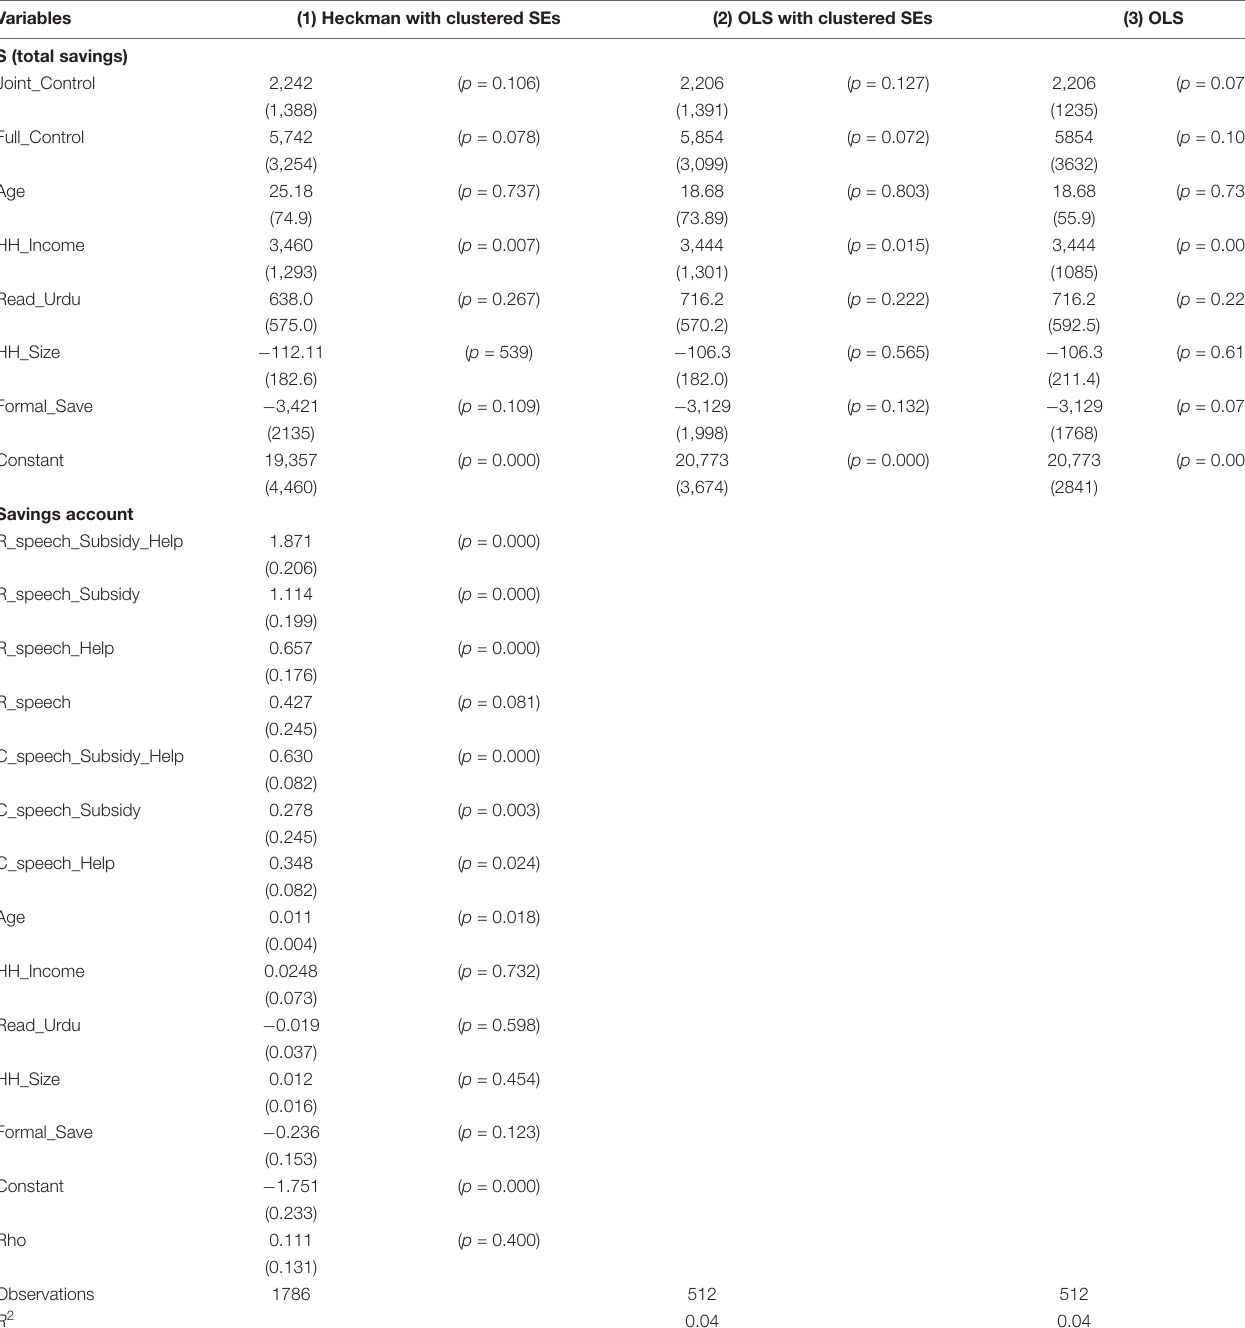
TABLE 4A | Robustness tests with total savings and No, Joint, and Full